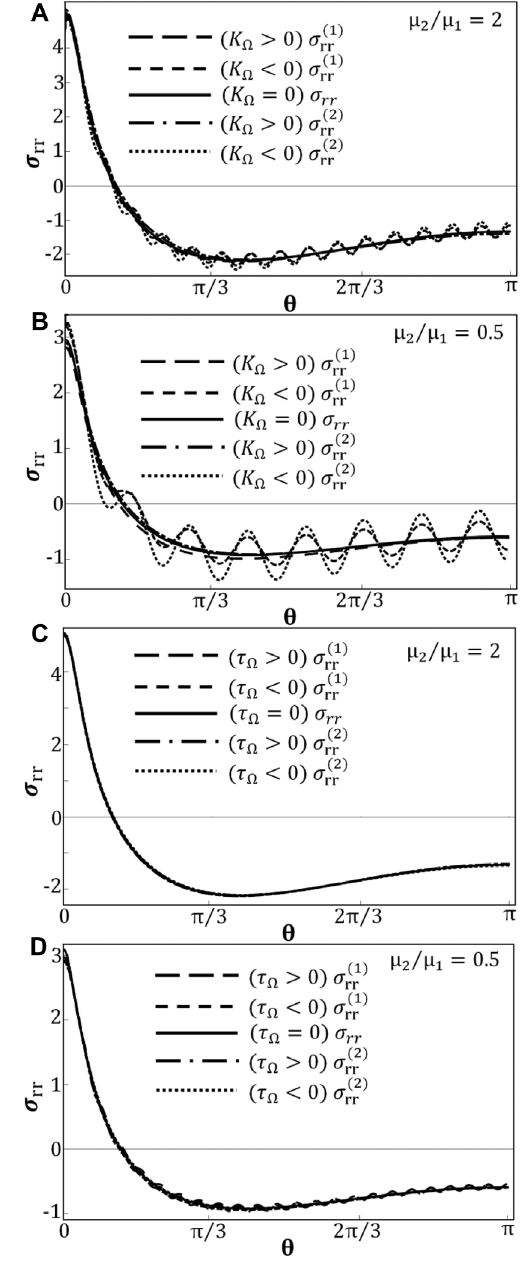
Figure 2 Distribution of the radial stress component along the = ν = 0.3, μ = 2 (A, C) nanowire/matrix interface for a = 2 nm, ν / μ 1 2 2 1 = 0 (A, B) and different and 0.5 (B, D), and different values of K at τ Ω Ω = λ = 0 (C, D). Stress values are given in units of values of τ at μ Ω Ω Ω μ ω /10. 1 σ and (2) σ are in particular the radial In Figure 2, (1) rr rr stress values on the inner and outer sides of the interface, σ respectively. As expected, the classical solutions for (1) rr σ are identical here, whereas the interface-elas- and (2) rr ticity (non-classical) solution is discontinuous across